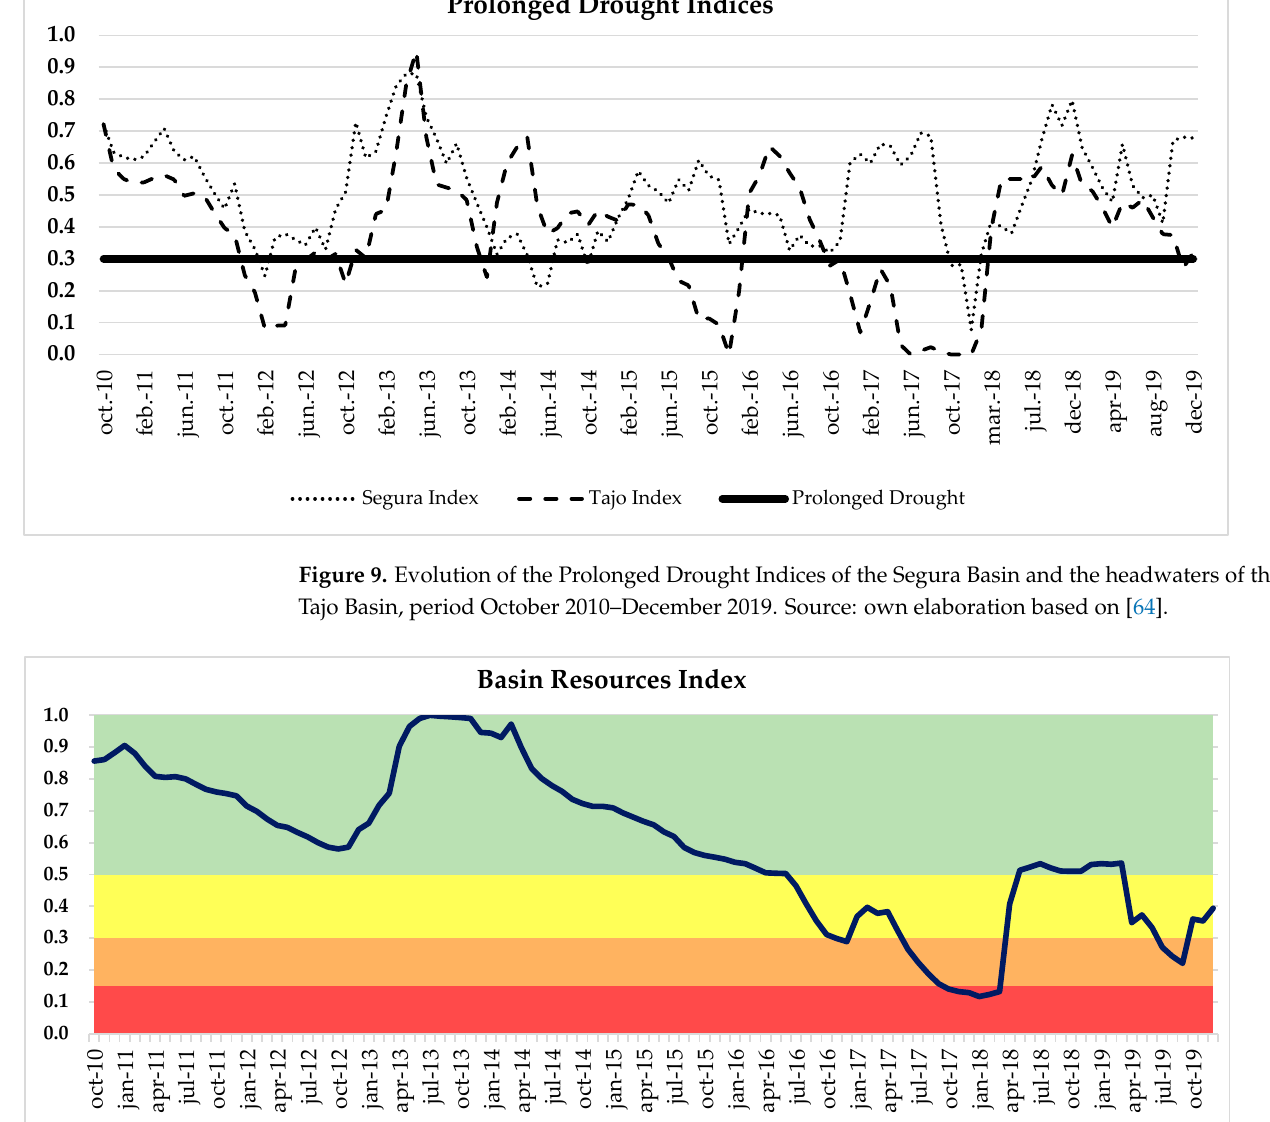
Figure 10. Evolution of the index of the basin resources (temporary scarcity) in the Segura Basin, period October 2010–December 2019. Source: own elaboration based on [64].